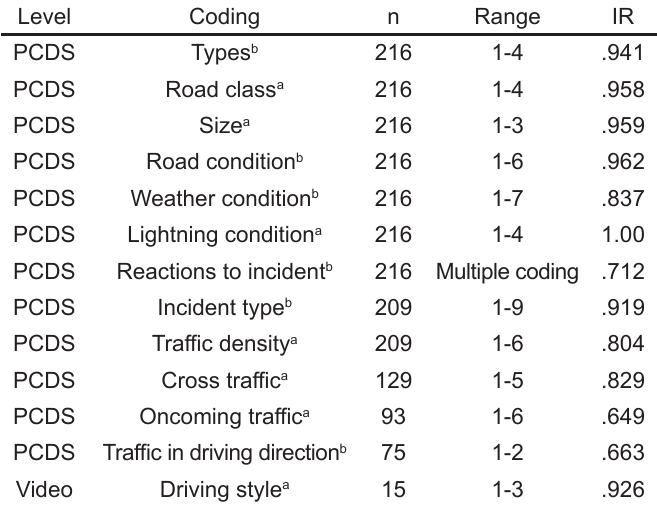
Table 2. Final interrater reliability of two raters (unit of analysis: potentially critical driving situations).